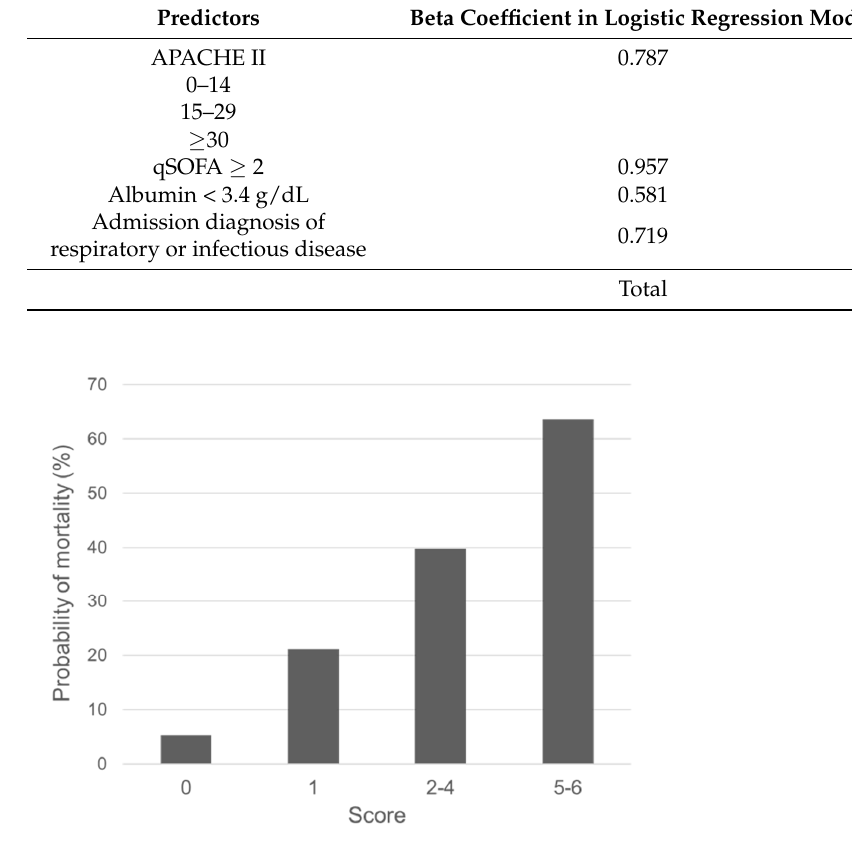
Figure 1. The probability of mortality according to the risk scores.